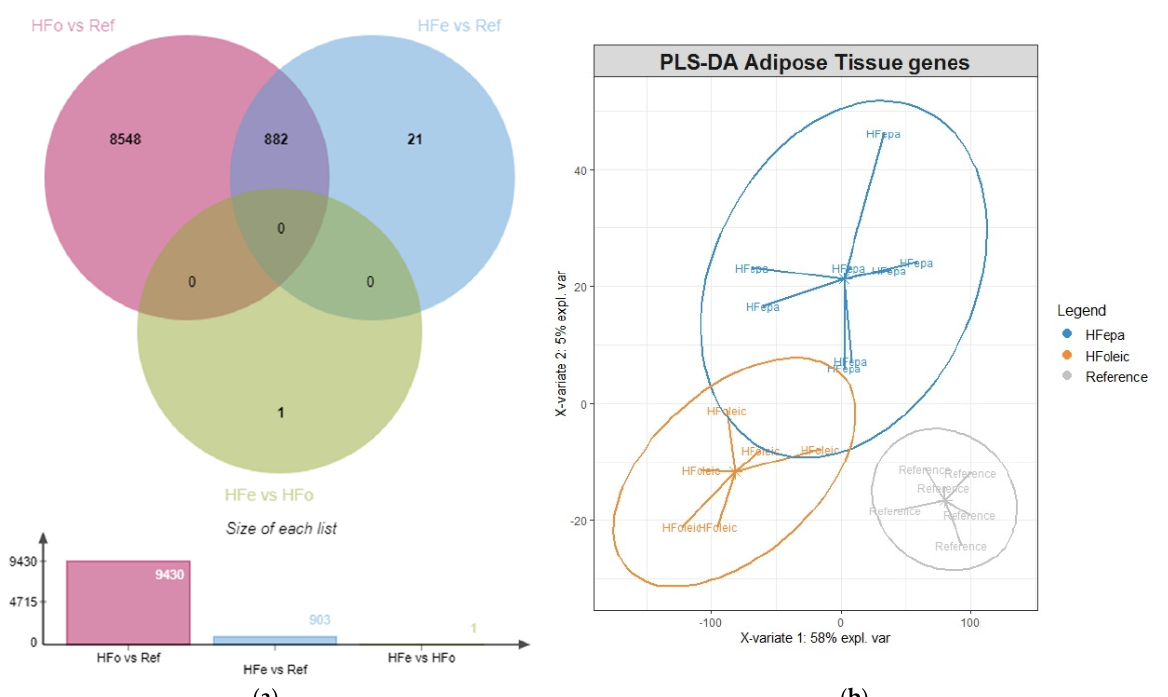
1026 were differentially expressed (903 unique genes, 532 over represented in HFepa, and 371 over represented in reference). Among the significantly regulated genes identified in the comparisons of HFoleic and HFepa against the reference group, 882 regulations